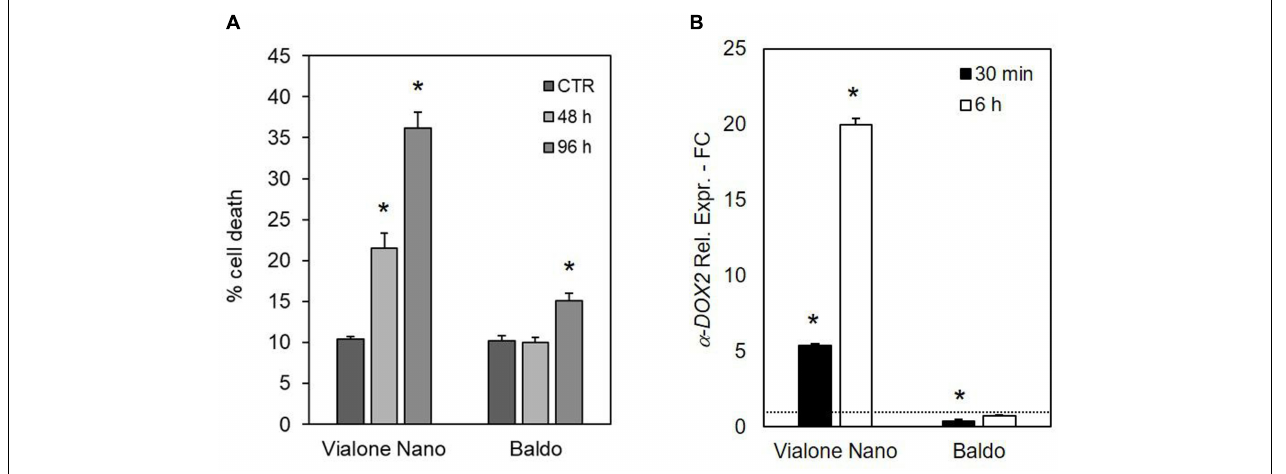
FIGURE 10 | Effects of glucose/GOX on suspension cell cultures. (A) Percent survival of treated cells after 48 and 96 h of treatment with 14 mM glucose plus 1 U ml − 1 GOX. (B) Expression profile of a-DOX2 gene after 30 min and 6 h of treatment with glucose/GOX. Values represent the mean ± SE of three independent experiments at least in duplicate. The asterisk indicates values that are significantly different from those of untreated cells according to Wilcoxon–Mann–Whitney’s test ( p < 0.01).